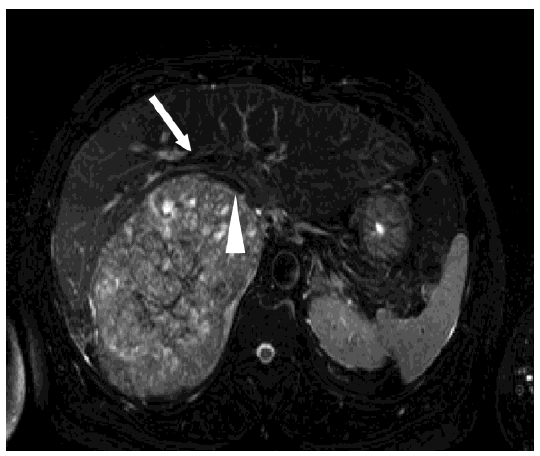
FIGURE 3. MRI shows mass in close proximity to IVC. Arrowhead demonstrates tumor and proximity/involvement of vena cava. Arrow demonstrates clear space between right portal